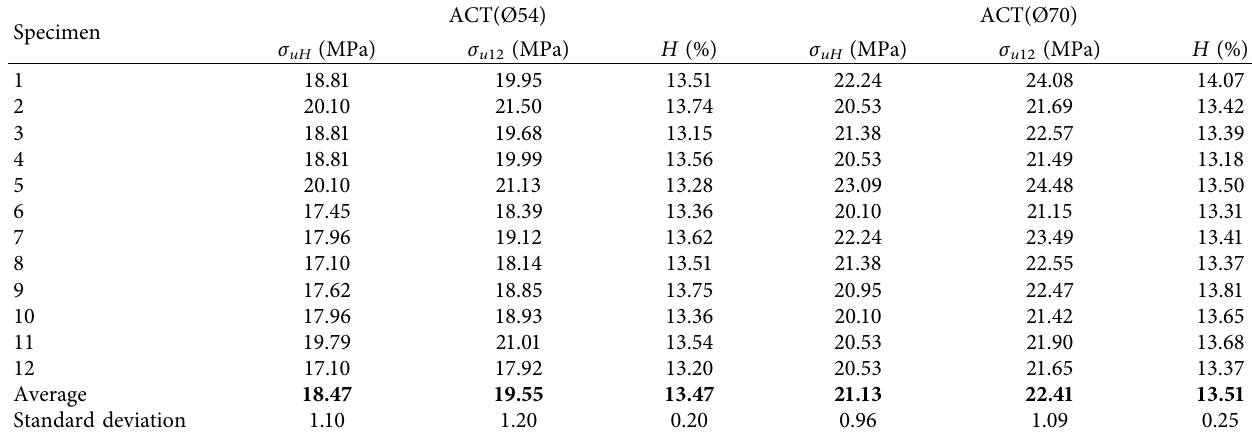
Table 8: Tangential compressive failure stresses, diameters 54cm and 70cm.